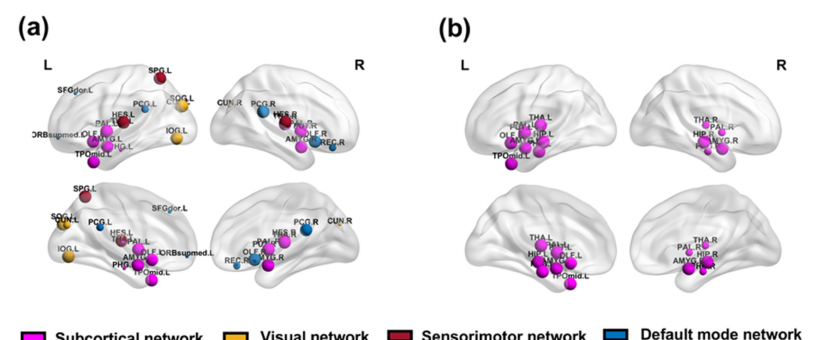
Figure 9. Cortical maps of damaged brain regions in schizophrenia. Panel ( a ) represents the cortical distribution of the damaged brain regions in the default mode network, sensorimotor network, visual network, and subcortical network of patients according to the entropy of the multiplex degree index. Panel ( b ) represents the cortical distribution of the damaged brain regions in the subcortical network of patients under the multilayer clustering coefficient index. The sizes of the nodes correspond to the significance of the difference between the groups. The smaller the p -value, the larger the node.